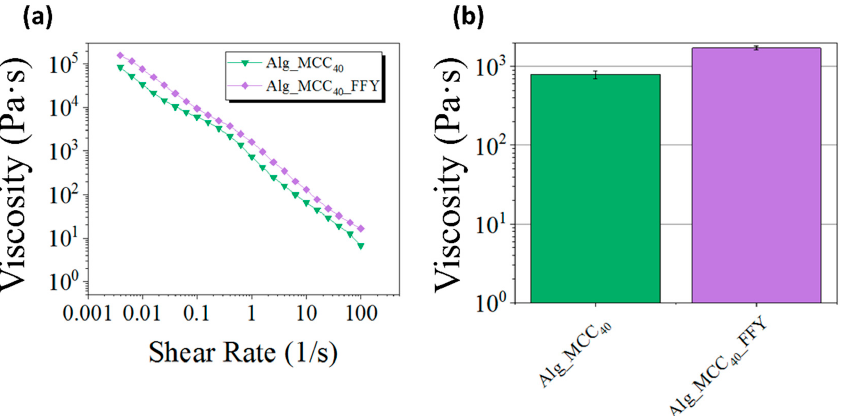
Figure 3. ( a ) The flow sweeps and ( b ) viscosity at a shear rate of 1 s − 1 of the different ink formulations containing MCC and with/without the Fmoc ‐ FFY peptide network. Next, the viscoelastic properties of the inks were measured by dynamic oscillatory rheology at 1 Hz. The linear viscoelastic regime was determined by the amplitude sweeps (Figure 4a), allowing us to obtain the yield strain, defined as the minimum strain needed to apply for the ink to start flowing (G” > G’). This value is related to the pressure needed for pneumatic ‐ based 3D printing, and, in our case, to the force needed by the step motor to push the piston of the syringe in piston ‐ based printing. The yield strain was found to be within the experimental error for the Alg_MCC 40 ink and the Alg_MCC 40 _FFY ink being ~45% for both. The self ‐ healing properties after printing were studied by dynamic step strain amplitude tests (Figure 4b) by varying the strain between 0.1% and 100% at short times (200 s). At low strains (0.1%), the inks showed the characteristic rheological behavior of a gel (G’ > G”). After applying a high strain (100%), G’ drastically decreased and a liquid ‐ like state was reached (G” > G’). Then, a gel ‐ like behavior was recovered once the samples were subjected to low strain (0.1%). Such behavior was observed even after two high–low strain repeated cycles and was associated with a self ‐ healing behavior and thee injectability properties of the inks. Next, frequency sweeps were performed in the linear viscoelastic region at 0.1% strain (Figure 4c). The storage modulus (G’) was higher than the loss modulus (G’) for both samples, which means that they showed the rheological behavior characteristic of a gel. From these frequency sweeps, the values of the storage modulus and Tan δ (Tan δ = G”/G’) at 1 Hz were calculated. The presence of the peptide within the alginate ink does not influence the obtained storage modulus of G’ = 22 ± 3 kPa for the Alg_MCC 40 ink and G’= 24 ± 3 kPa for the Alg_MCC 40 _FFY ink. These moduli are in the range of those reported in the literature for alginate–cellulose inks that report values from the order of hundreds of Pa [24] to the order of several kilopascals [13,46]. Likewise, the value of the Tan δ = 0.3 was found to be within the experimental error for both inks, with this value of Tan δ in the printable range as defined by other studies (0.25–0.45) [16].